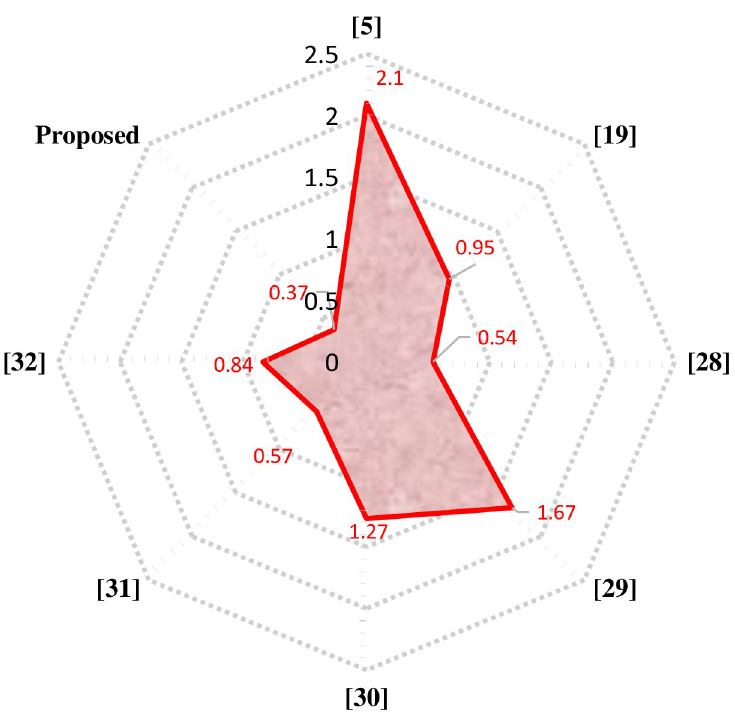
Fig 29. Comparison of 81-level MWMLI with various topologies for the components per level factor as a parameter.